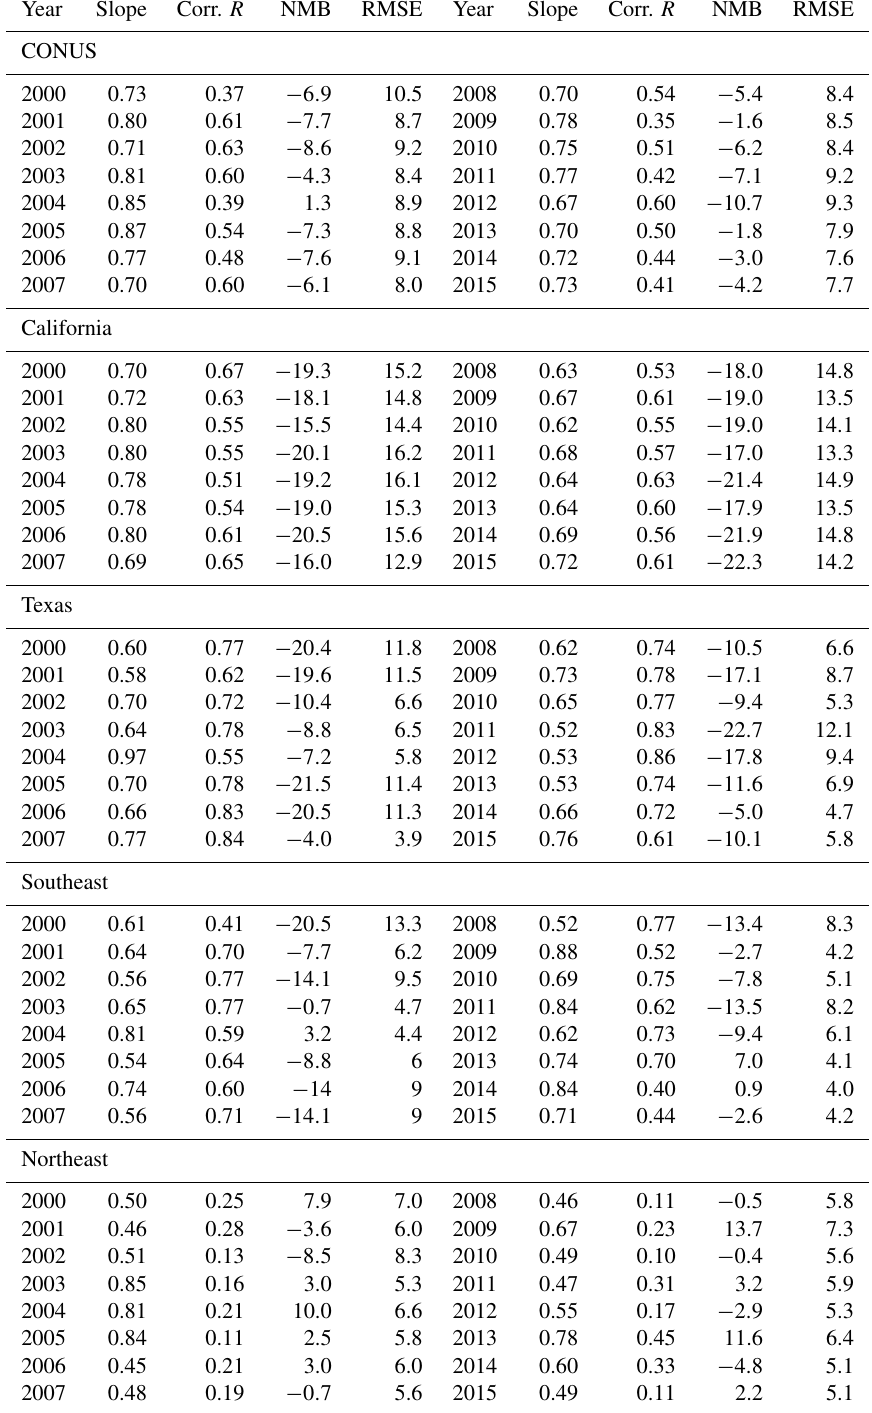
Table 2. Summary of the comparison of JJA MDA8 ozone concentrations from AQS observations and CMAQ simulations during 2000–2015 in the CONUS and subdomains. Slope and correlation (corr. R ) are calculated for each year based on linear regression analysis. Please note that our California and Texas subdomains include more area than the states of California and